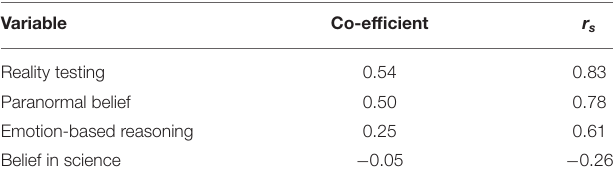
TABLE 3 | Standardized canonical discriminant function coefficients and structure matrix of ability.